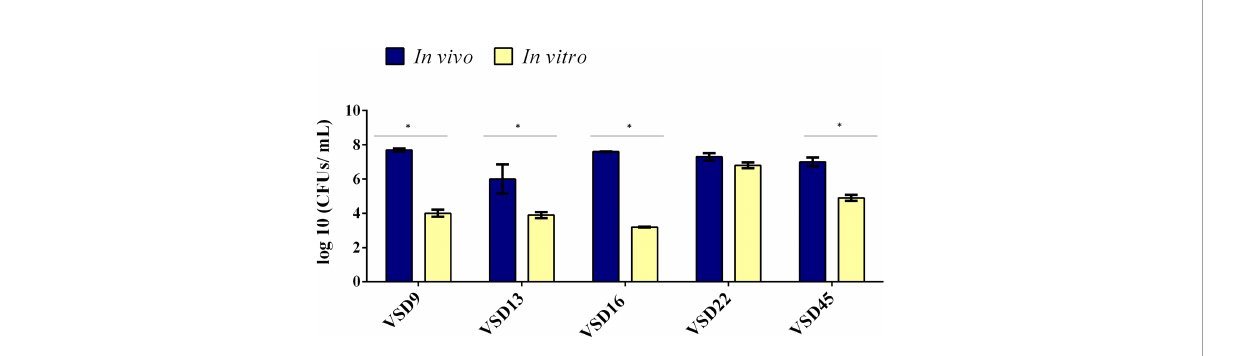
FIGURE 4 Comparison of bio fi lm development by bovine SDSD isolates recovered from catheter implanted in mice and by the in vitro assay. Statistically signi fi cant differences were observed in the formation of bio fi lms in vivo and in vitro , * p <